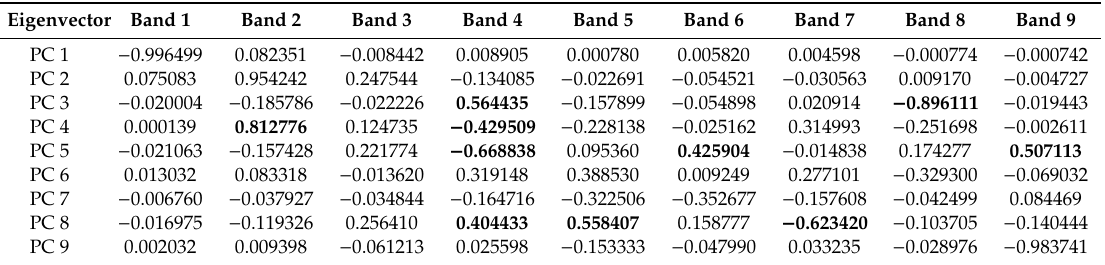
Table 4. Eigenvector matrix derived from PCA for the selected bands of ASTER bands (VNIR + SWIR) used in this study.